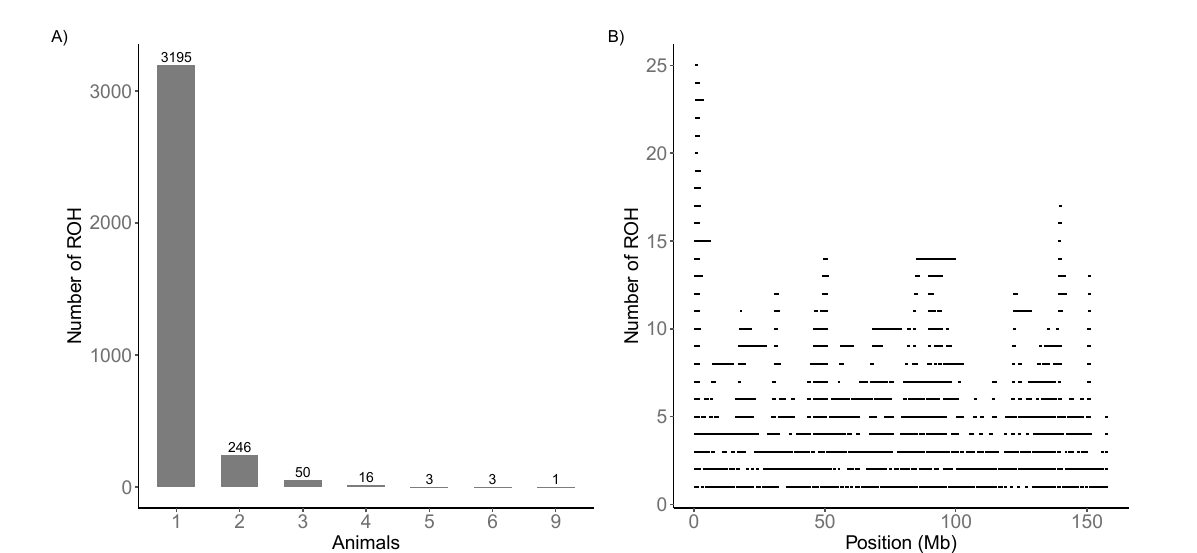
Figure 3. ( A ) Specific runs of homozygosity (ROH) distribution. ( B ) Stacked runs in chromosome 1. Inbreeding coefficients based on pedigree and genomic information for the 71 geno- typed animals are shown in Table 3. Considering all detected ROH (i.e., >1 Mb), the average F ROH was 7.28%, and it decreased as the minimum length of ROH increased. This result reflects a decreased number of ROH identified as shorter ROH segments were excluded when longer ROH classes were considered. The average F ROH was 1.44% considering the >16 Mb class (Table 3), and this can be attributed to the fact that only a few ROH segments larger than 16 Mb were found. The number of inbred animals in the other ROH classes varied. The total number of inbred animals was 71 for F ROH > 1 Mb or > 2 Mb, 68 for F ROH > 4 Mb or > 8 Mb, and 27 for F ROH > 16 Mb. The largest F ROH value was observed